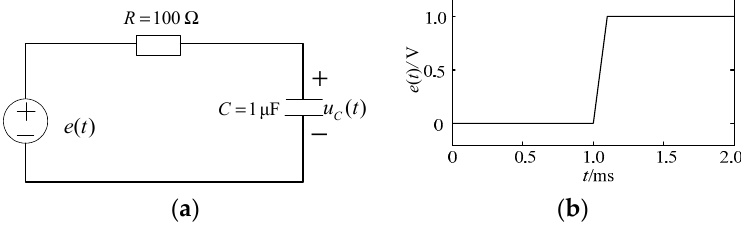
Figure 12. RC (resistance and capacitor) series test circuit and its excitation source. ( a ) RC series test circuit; and ( b ) excitation source waveform in the RC test circuit.